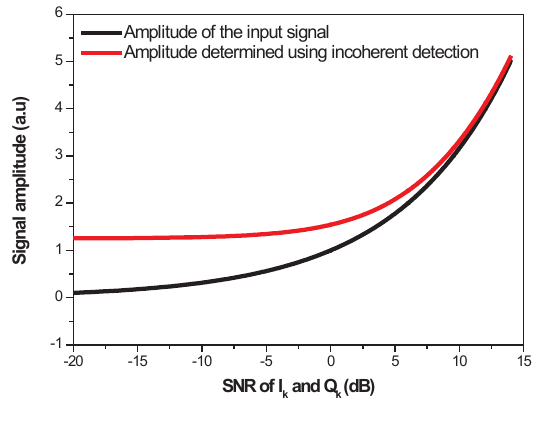
Figure 3. Mean estimate of A in the case of incoherent detection